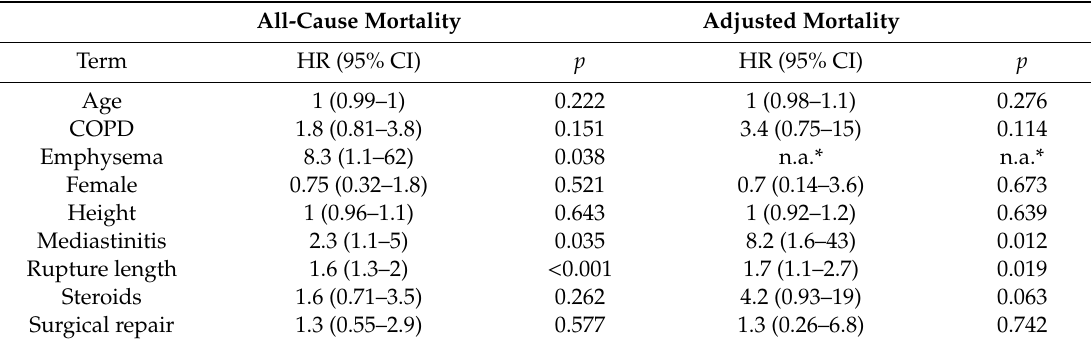
Table 3. Univariate analysis for survival of iatrogenic tracheal rupture. All-Cause